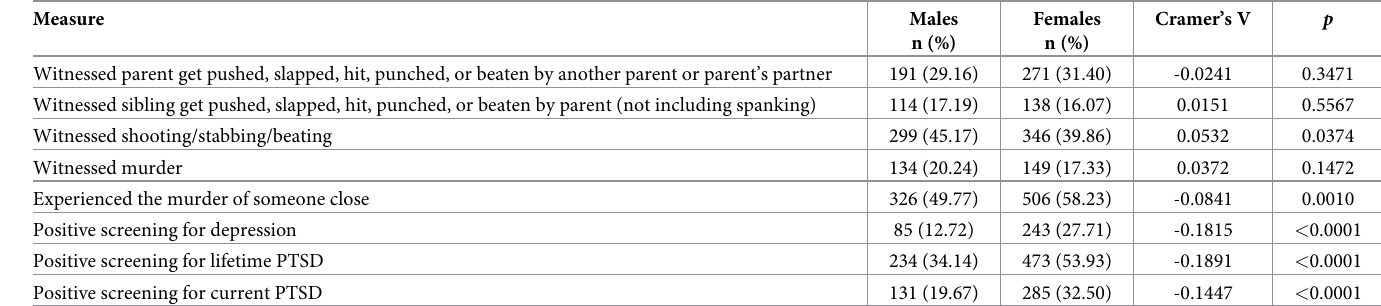
Table 2. Indirect exposure to violence and adverse mental health symptomatology by gender (N = 1548).